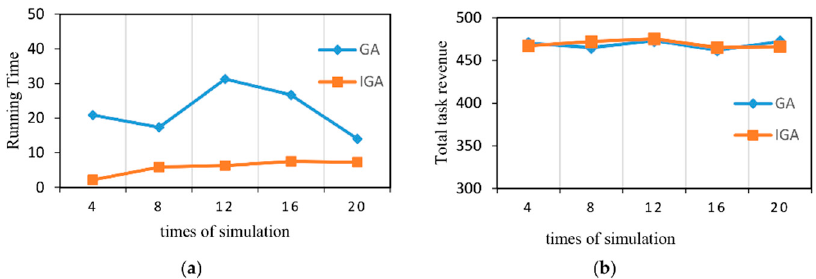
Figure 11. The result of Experiment 2. ( a ) The running time of Experiment 2 and ( b ) the task revenue of Experiment 3.